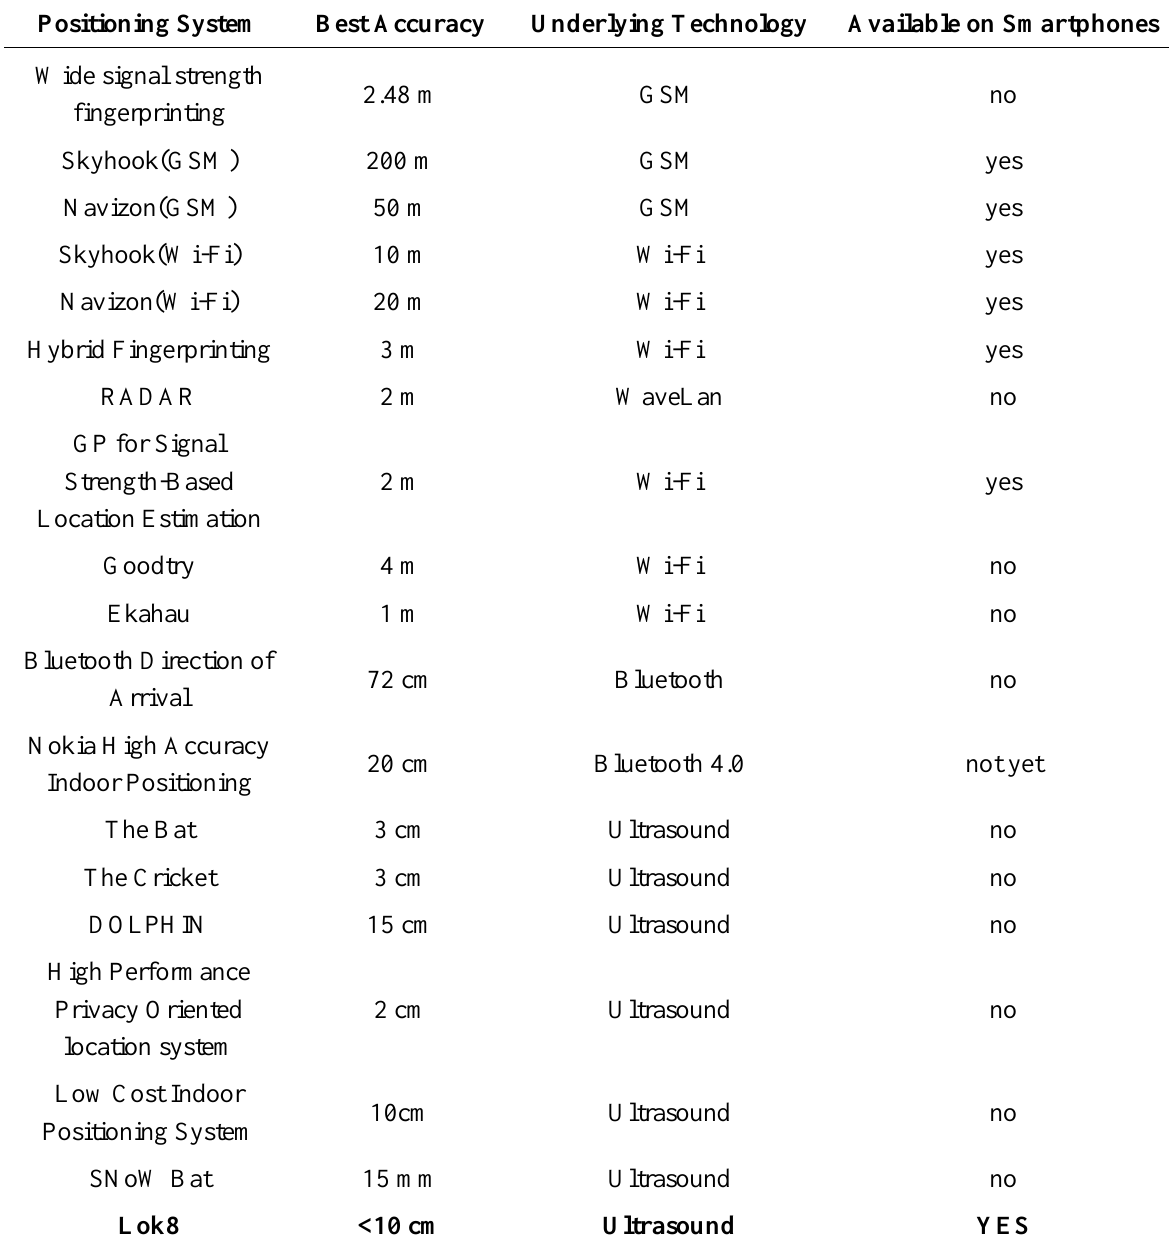
Table 1. Comparison of indoor positioning system